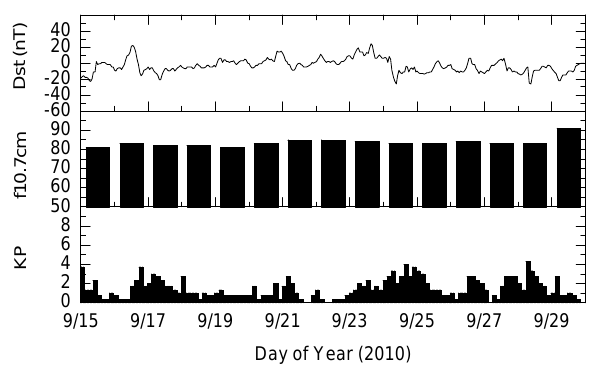
Fig. 15. Dst, F 10 . 7 , and K p indices during 15–29 September 2011.